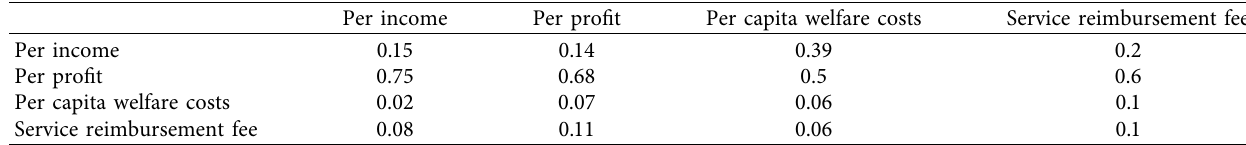
Table 3: Normalization table of analytic hierarchical process in financial perspective.